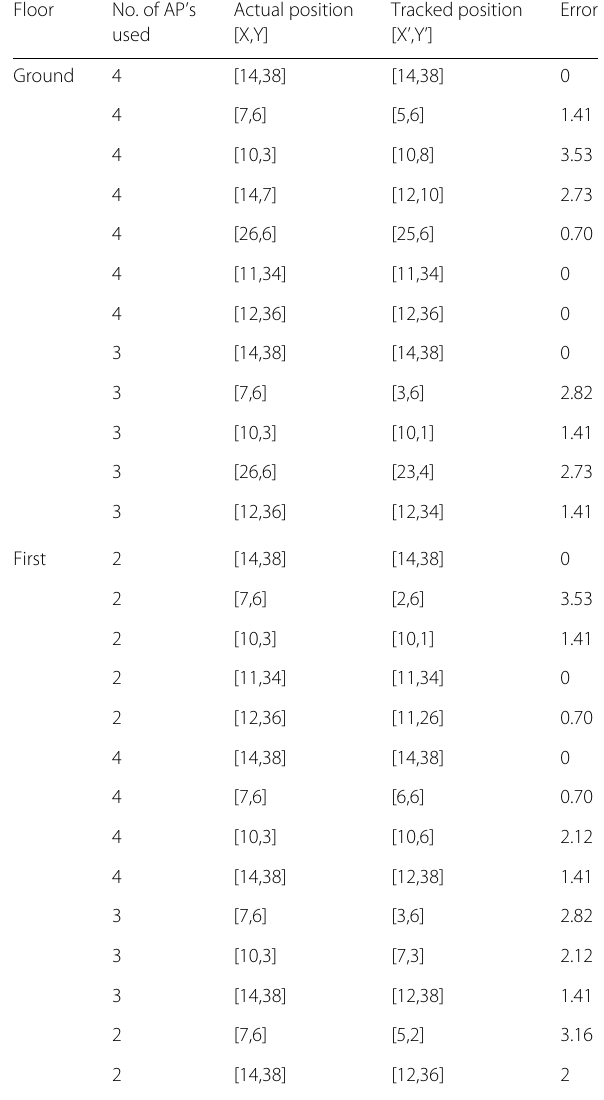
Table 1 Tracking results for ground